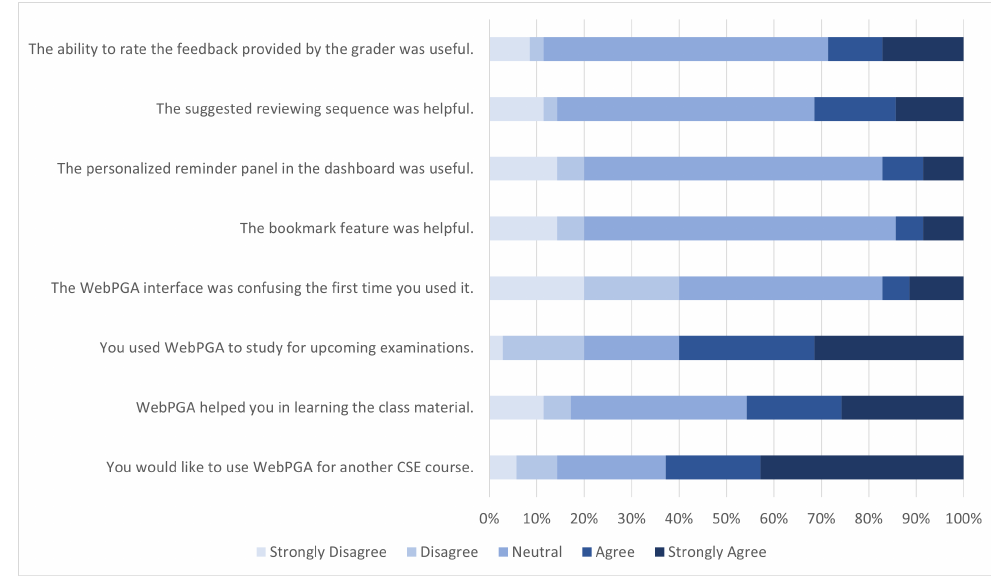
Figure 4. The following illustrates the responses 35 students (22.29%) to an anonymous survey administered at the end of the semester. This served as a subjective evaluation of the